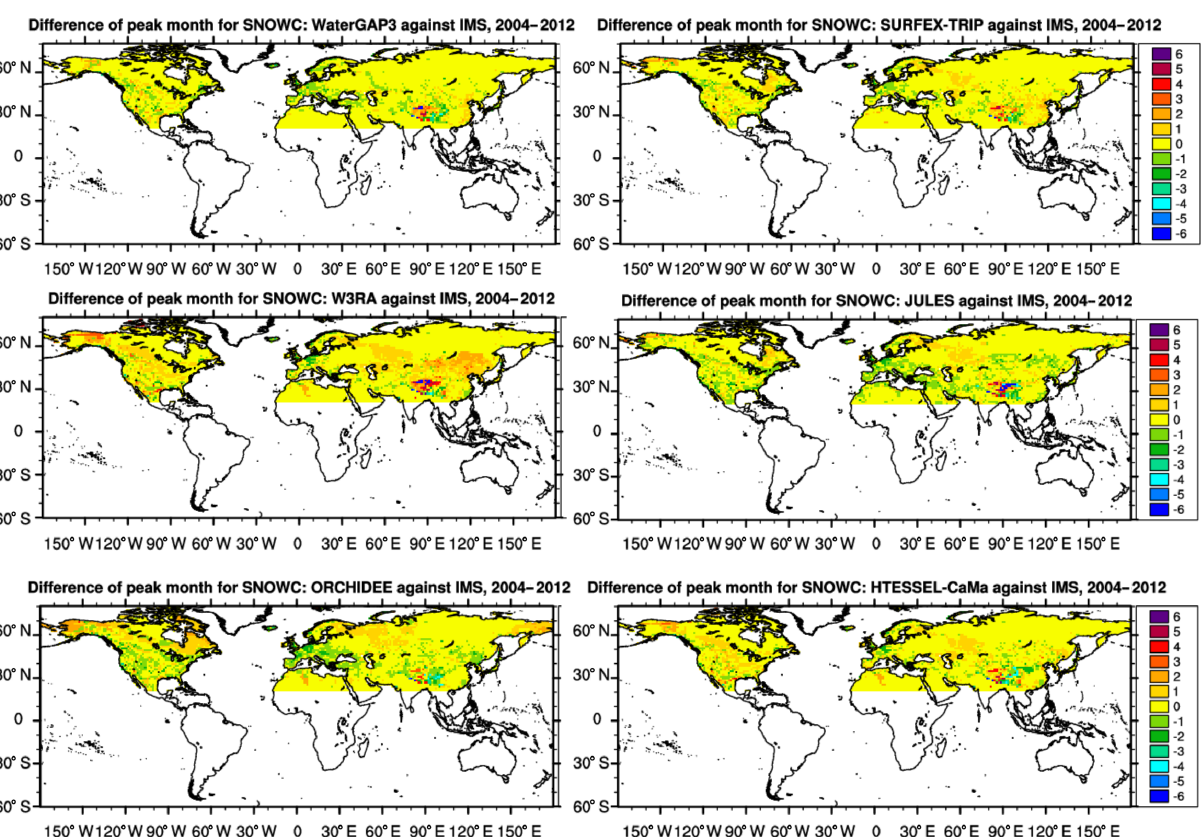
Figure 7. Difference in peak snow cover (SC) month for the models compared to the IMS